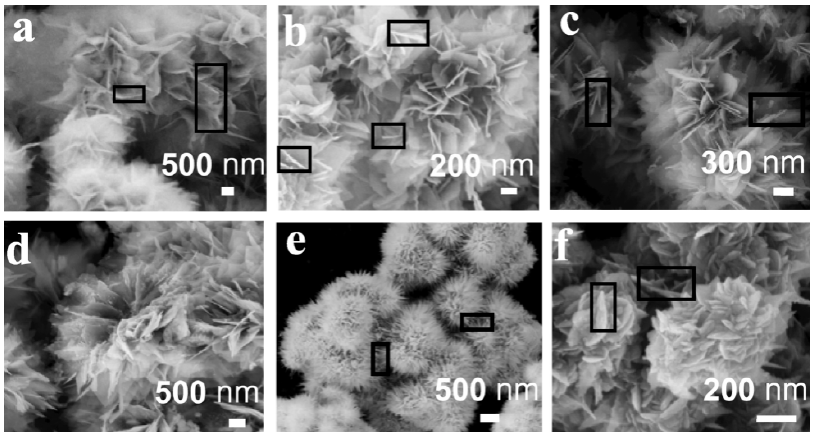
Figure 6. FESEM images of SnO 2 nanoflowers when the molar ratio OH − to Sn 2 + was ( a ) 4/1, ( b ) 5/1, ( c ) 6/1, ( d ) 7/1, ( e ) 8/1, and ( f ) 10/1, respectively [51].